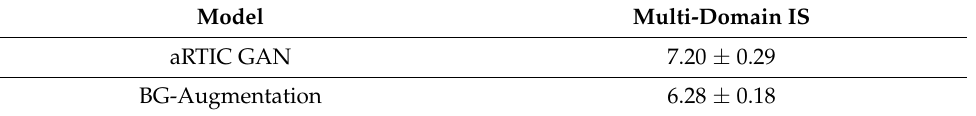
Table 3. The IS of the standard aRTIC GAN is compared with the BG-Augmentation